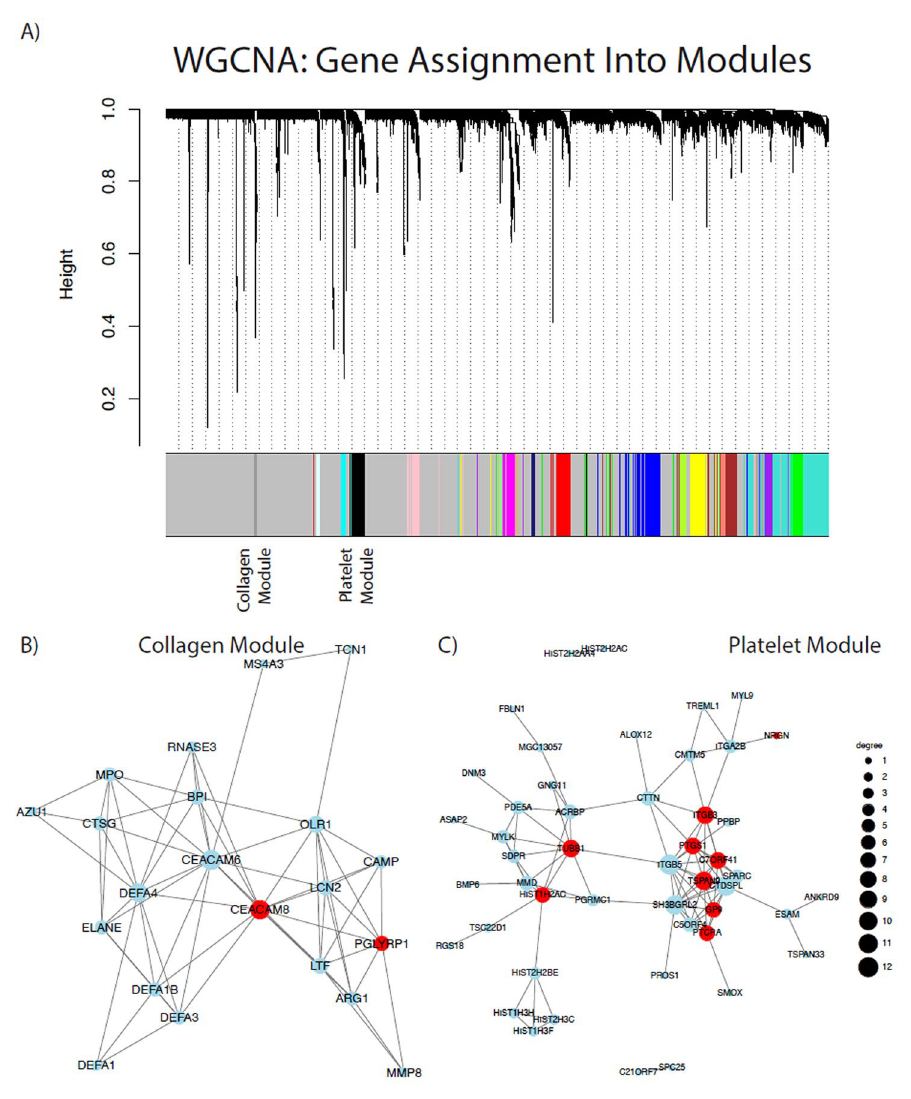
Figure 2. Weighted Gene Coexpression Network Analysis: (WGCNA) ( A ) WGCNA module clustering ( B ) Correlation networks within Collagen Module and ( C ) Platelet